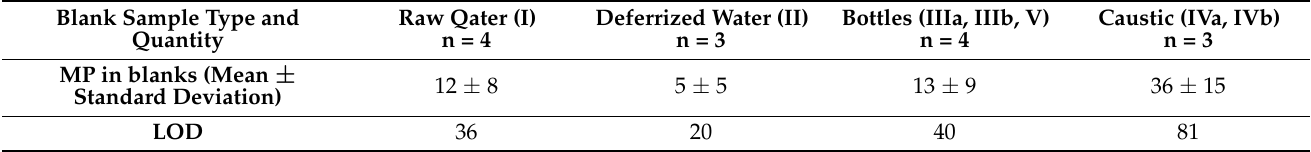
Table 1. MP in blank samples and calculated LOD for each sample type, rounded to integers. Blank Sample Type and Quantity